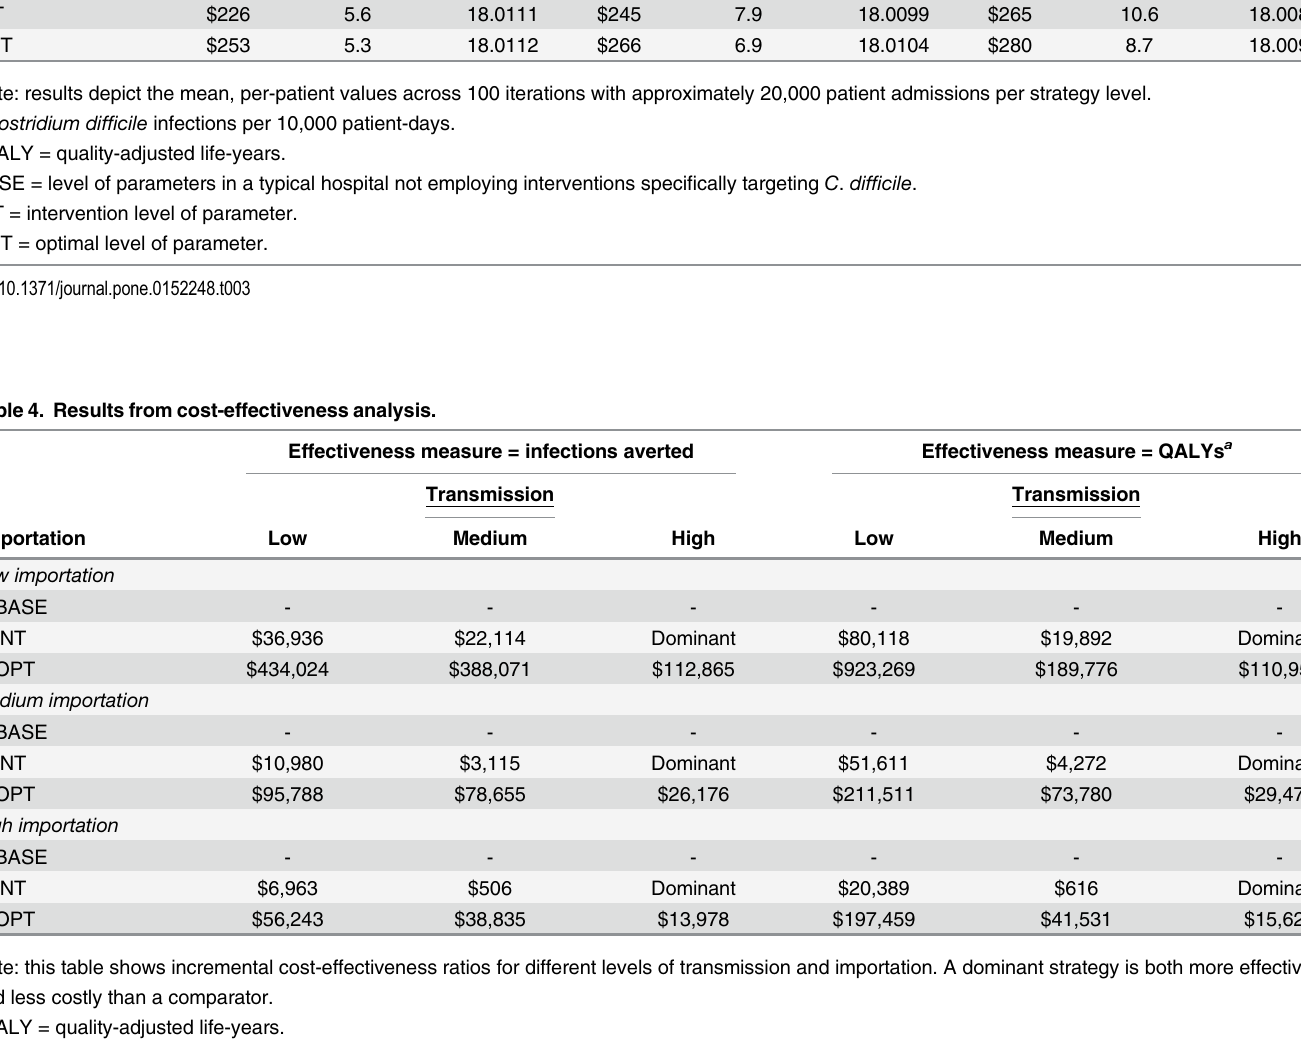
PLOS ONE | DOI:10.1371/journal.pone.0152248 March 31, 2016 8 /